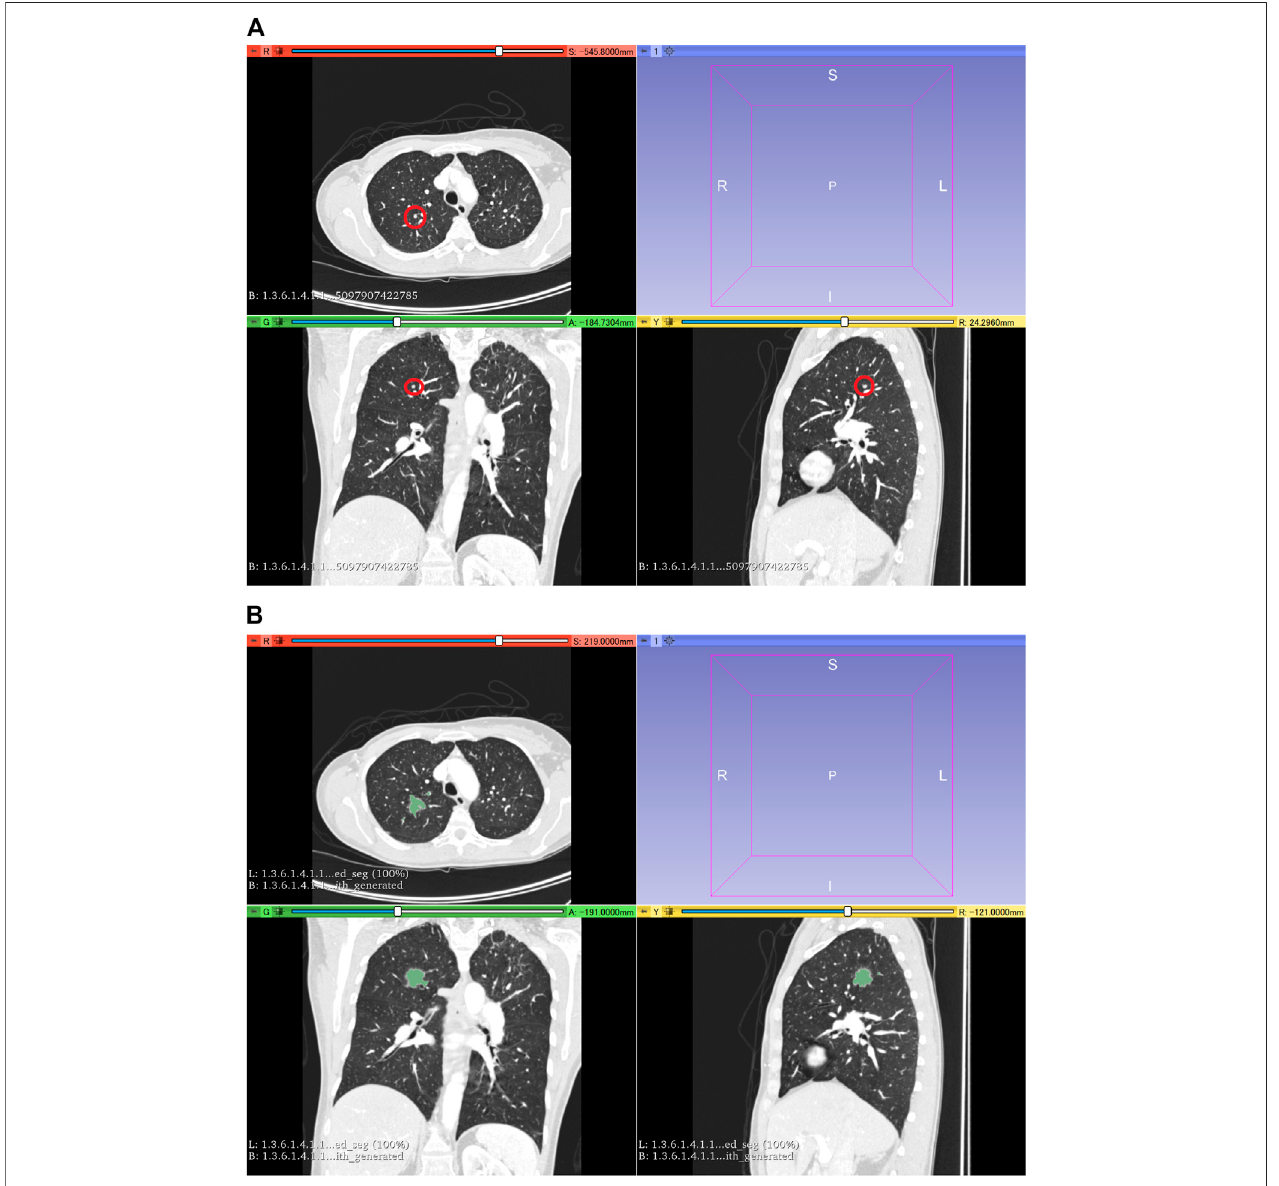
FIGURE 2 | 3D CT images of the chest. (A) Original CT images in the LUNA16 dataset. The red circle represents the true nodule speci fi ed in the LUNA16 dataset. (B) Lung nodule is arti fi cially generated at the location of the true nodule. Label obtained with the 3D graph cut is superimposed on the 3D CT